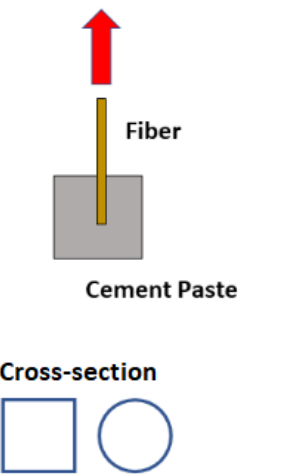
Figure 3. Group 3: Typical pull-out test configuration of a fiber element embedded in a cement- based